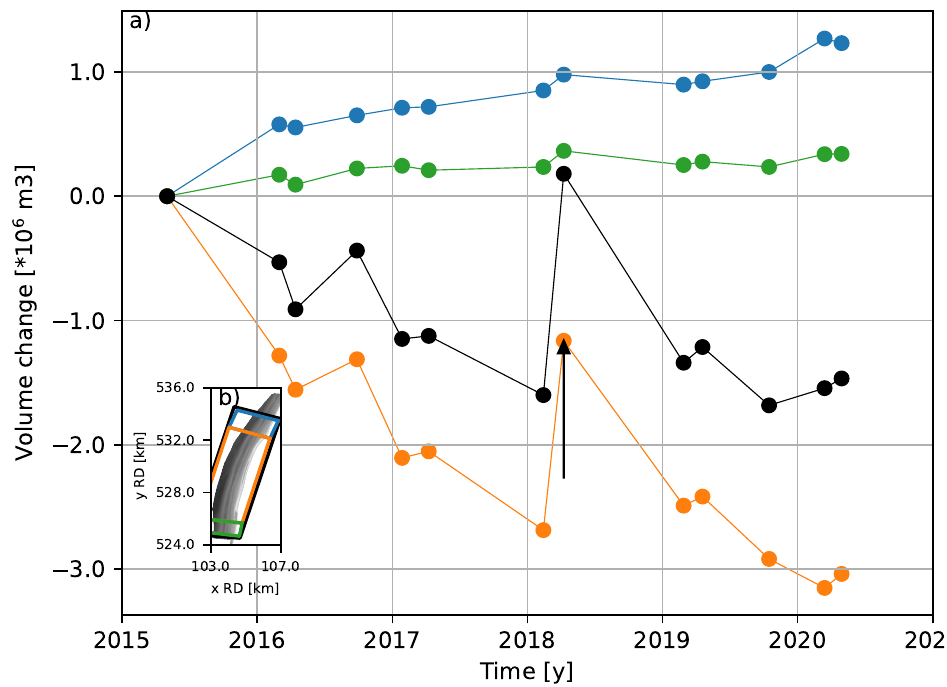
Figure 7. Volume change above − 10 m + NAP since April 2015 in three alongshore sections. ( a ) The center of the project (km 20.23 to 27) (orange), the adjacent beach north (km 18.8 to 20.23) (blue), the adjacent beach south (km 27 to 28) (green), and the total volume change for all sections combined (black). The black arrow indicates the moment and size of the additional 2018 nourishment of ± 1 · 10 6 m 3 . ( b ) Top view of the nourishment and locations of the volume